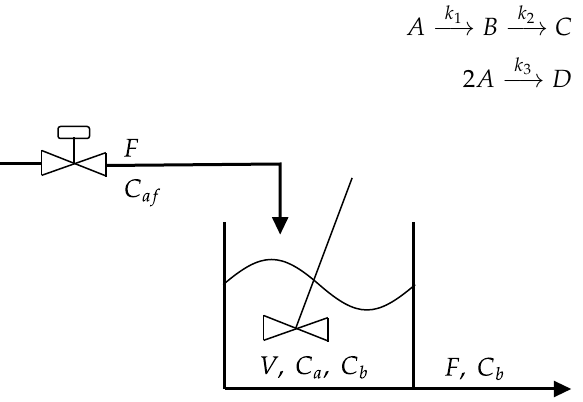
Figure 6. Van de Vusse